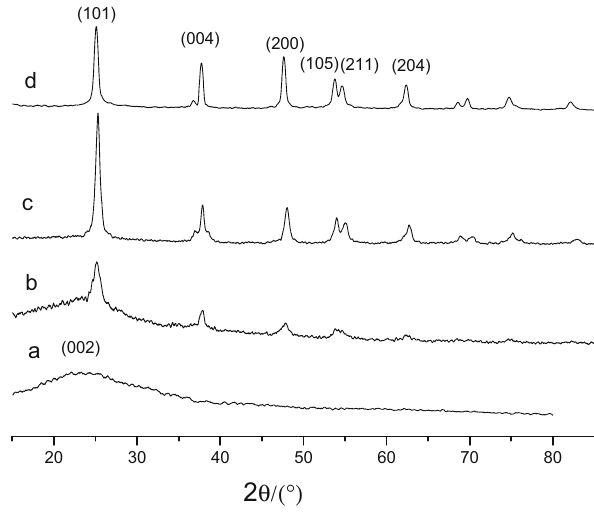
Figure 8: XRD of di ff erent samples: ( a ) carbon microspheres; (